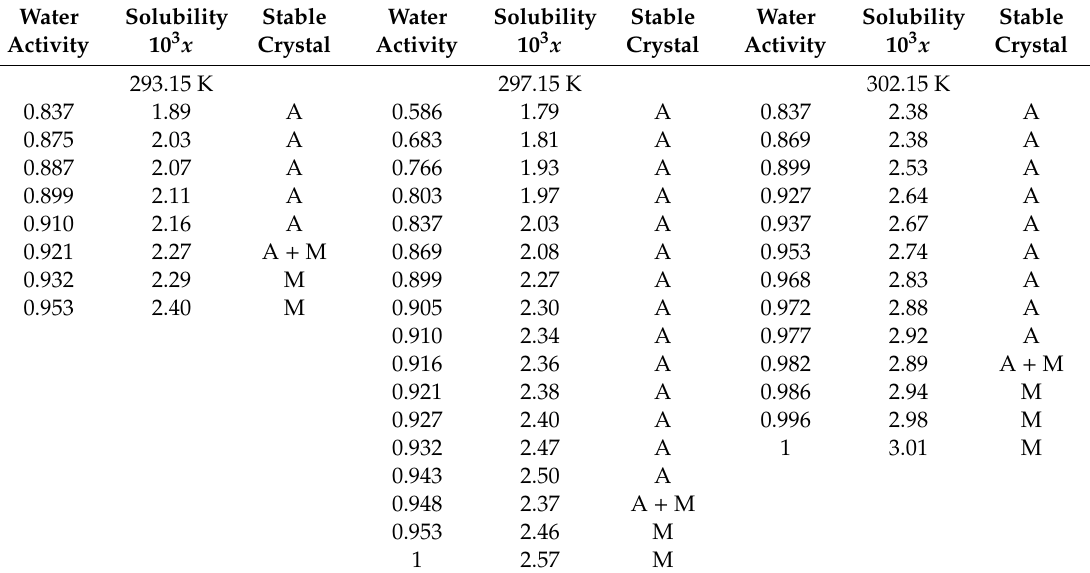
Figure 3. The XRD patterns of L-Phe in di ff erent water activities: ( a ) 293.15 K, ( b ) 297.15 K, ( c ) 302.15 K and ( d ) at equilibrium. Table 3. Mass fraction solubility data of anhydrous or monohydrate L-Phe in a mixed solvent at temperatures 293.15 K, 297.15 K and 302.15 K.